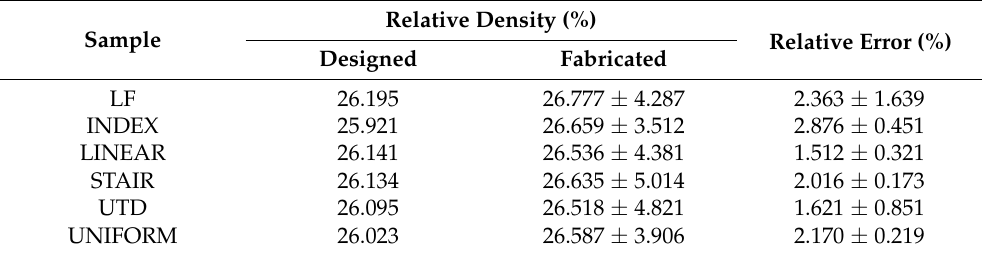
Figure 3. Optical microscope (OM) observation of the macroscopic morphology of the lattice structure ( a , b ); SEM micrographs of the struts with different diameters ( c , e ) and at the nodes ( d ), and energy spectrum analysis of the spherical particles on the surface of the strut ( f ). Table 2. The measurement of structural characterizations for the as-built lattice structures.